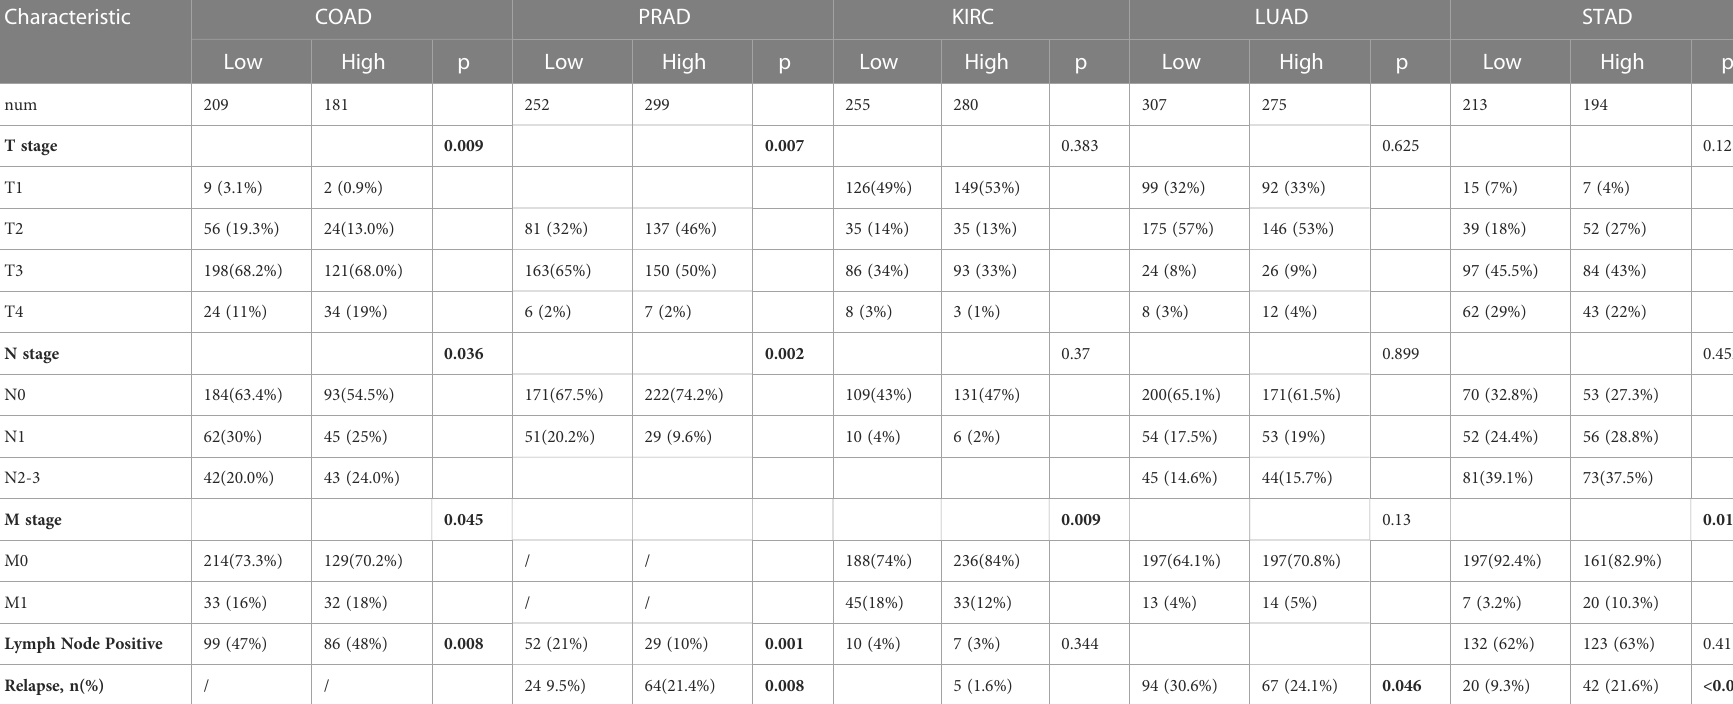
TABLE 1 Relation of GPX3 expression and the clinical characteristic of patients with cancers.